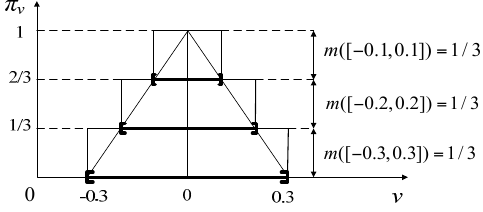
Figure 8. Probability distribution π v of state noise v .